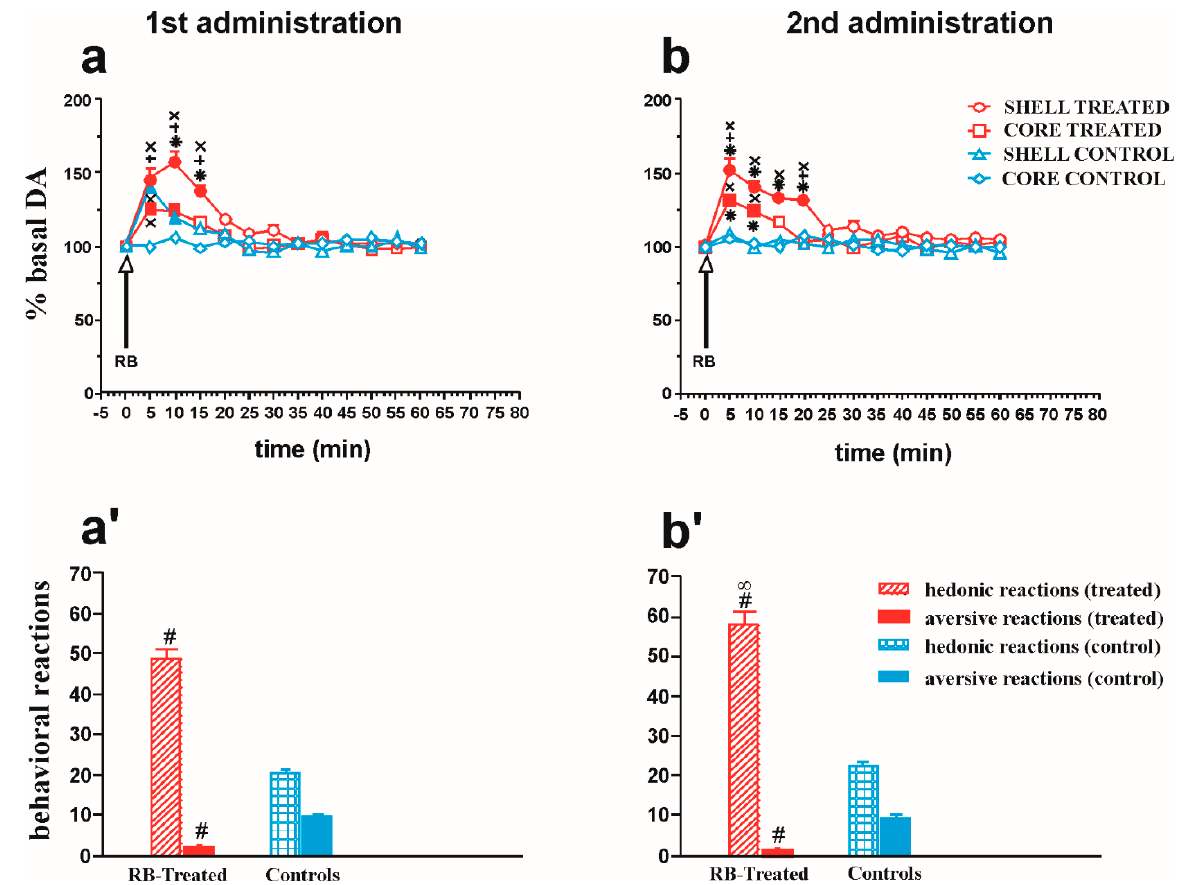
Figure 4. Changes in NAc shell and core dialysate DA after two subsequent intraoral administrations of RB (2 mL) in RB-treated and control rats. Figure 4 also shows the score of hedonic and aversive taste reactions during intraoral RB infusion. ( a , b ) DA transmission: filled symbols p < 0.001 vs. basal value; * p < 0.05 vs. DA responsiveness in the shell of control rats; + p < 0.05 vs. DA responsiveness in the core of RB-treated rats; × p < 0.05 vs. DA responsiveness in the core of control rats. ( a’ , b’ ). Statistical analysis: four-way ANOVA. Taste reactions: # p < 0.001 vs. control rats; ∞ p < 0.001 vs. first administration. Statistical analysis: two-way ANOVA.